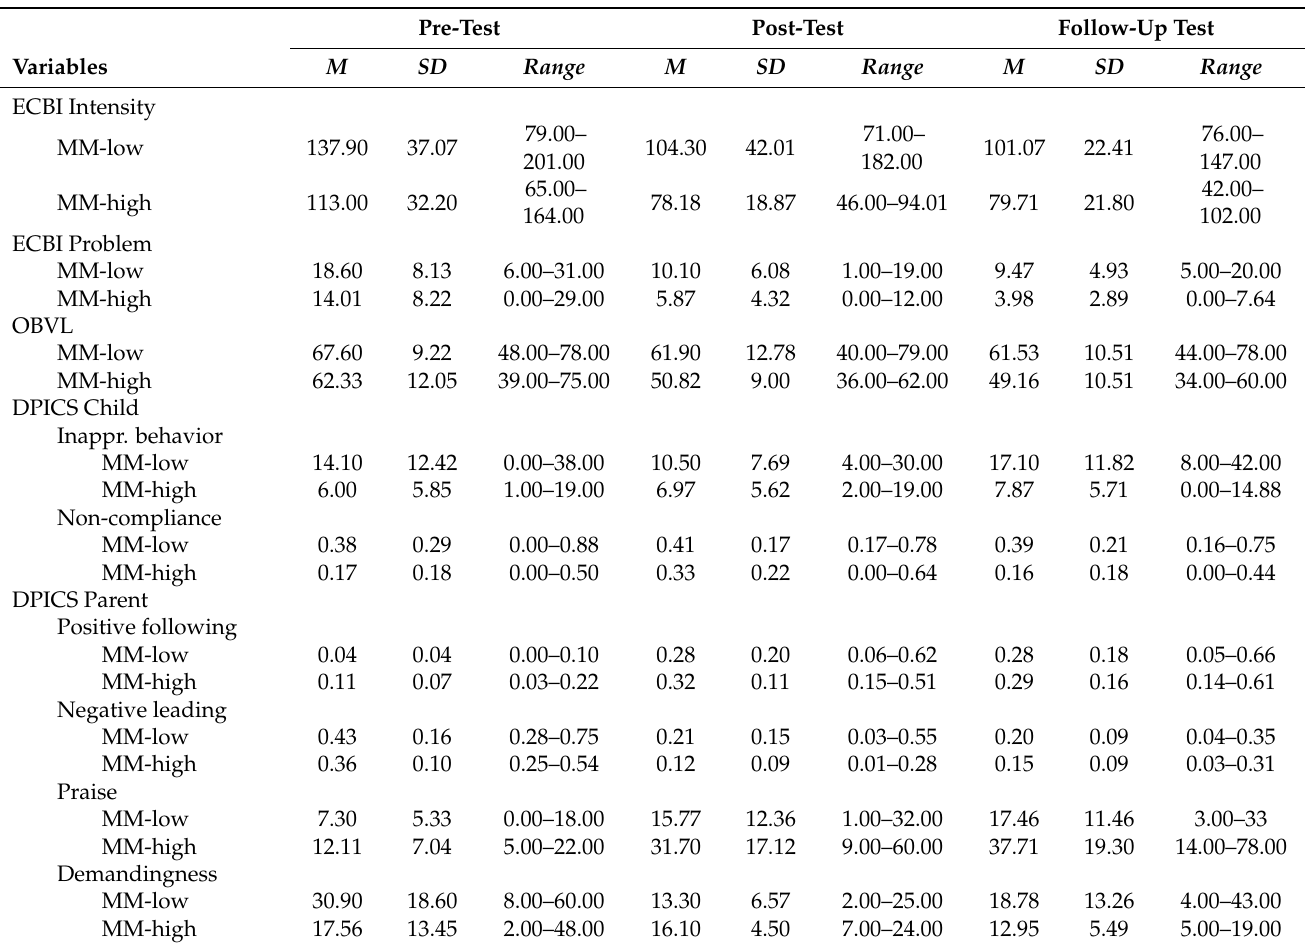
Table A1. PCIT-Home results for mind-mindedness: descriptives (means, standard deviations, and